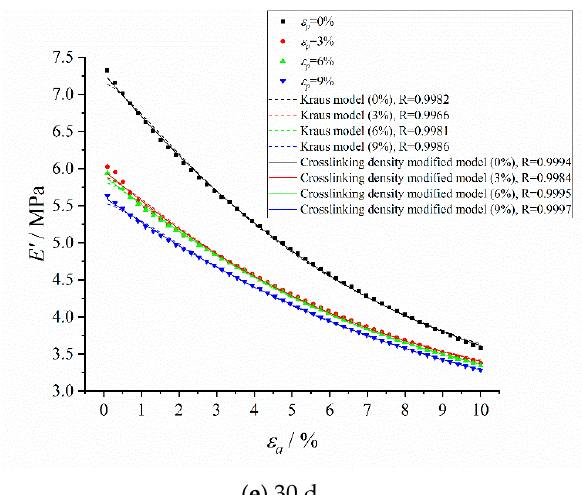
Figure 14. The storage modulus fitting curves of the crosslinking density modified model and Kraus model under pre-strain. ( a ) Aged for 0 d; ( b ) Aged for 6 d; ( c ) Aged for 12 d; ( d ) Aged for 20 d; ( e ) Aged for 30 d.